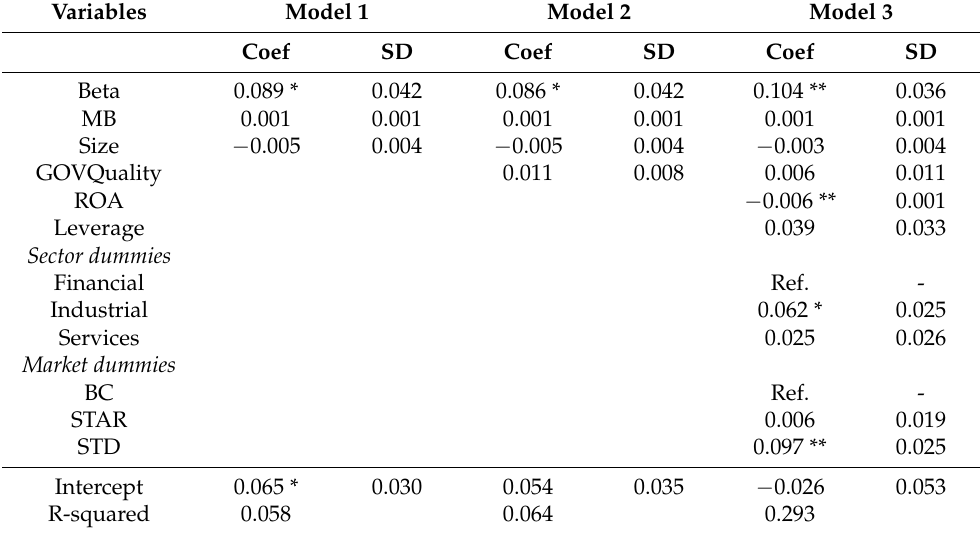
Table 4. Regression analysis results.